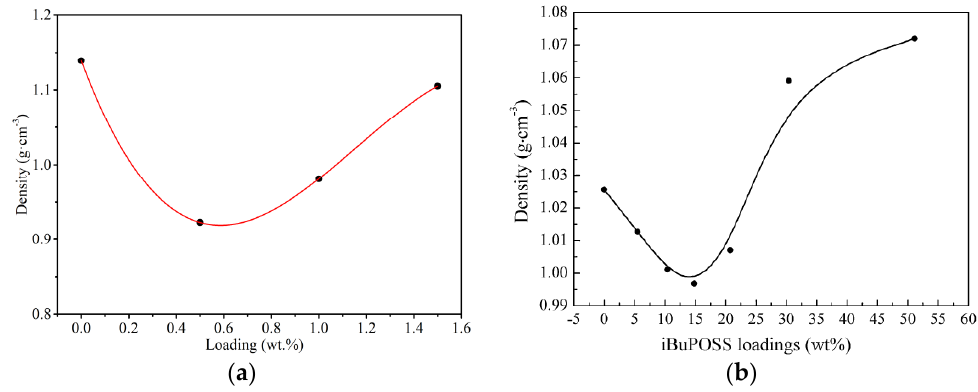
Figure 10. The correlation between the nanocomposite membrane density and the nanoparticle loading: ( a ) Polyvinyl Alcohol (PVA)–Graphene oxide (GO) [55]; ( b ) Poly(methyl methacrylate) (PMMA)–isobutyl (iBuPOSS) [57].